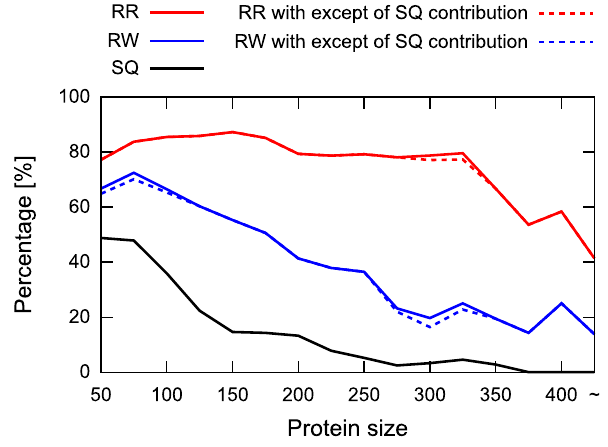
Figure 5. Analysis of the target size dependence. The percentage of target proteins with a TM-score of the SQ, RW, and RR templates equal to or greater than 0.5 as a function of the target protein size is presented. The horizontal axis represents the sequence length of the target proteins. The vertical axis represents the percentage of the target proteins with the TM-scores of SQ, RW, and RR templates equal to or greater than 0.5 for a given target size. The lines are colored in black, blue, and red for the SQ, RW, and RR templates, respectively. The dotted lines correspond to the data in which the contributions of protein folds that exhibit topological similarity to the target proteins are excluded.